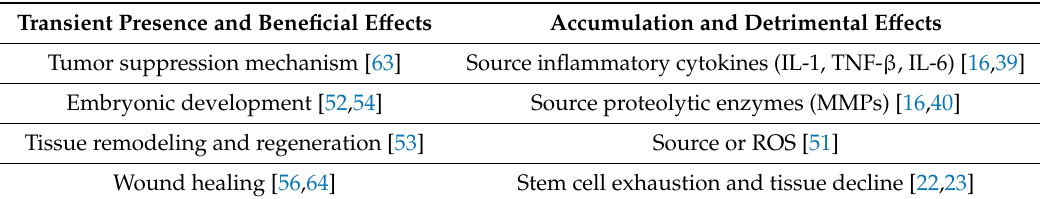
Table 1. The role of senescent cells depends on the